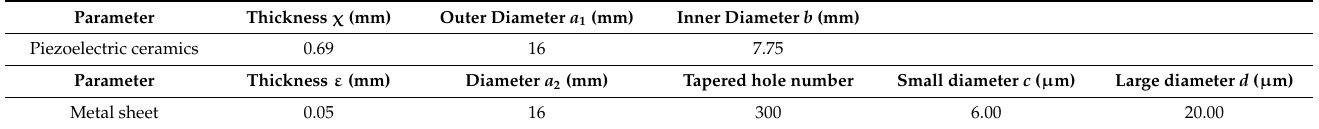
Table 1. Atomizing sheet structure parameter table.